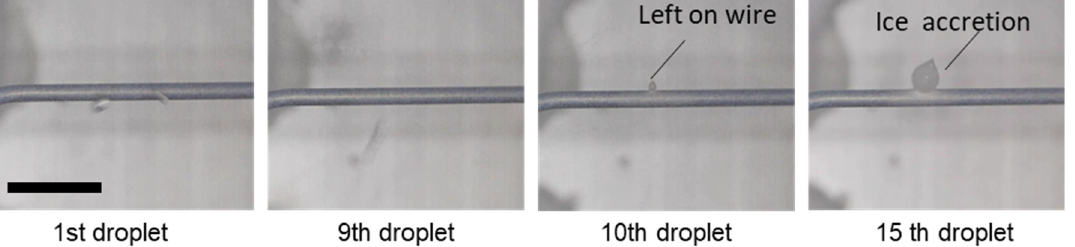
Figure 7. Freezing process of impacting droplets of 15 µL at 1.5 m/s ( We = 94) on the superhydro- phobic wire at − 20 °C. The first two images show the superhydrophobic wire after the impact by the first and the ninth droplet, respectively, showing no ice accretion on the wire. The third image shows the superhydrophobic wire after the impact by the tenth droplet, showing the noticeable accretion of ice on the wire. The last image shows the superhydrophobic wire with the increase in the ice accretion after the impact by the fifteenth droplet. The droplets are let to impact the wire every one minute. Scale bar is 3 mm.